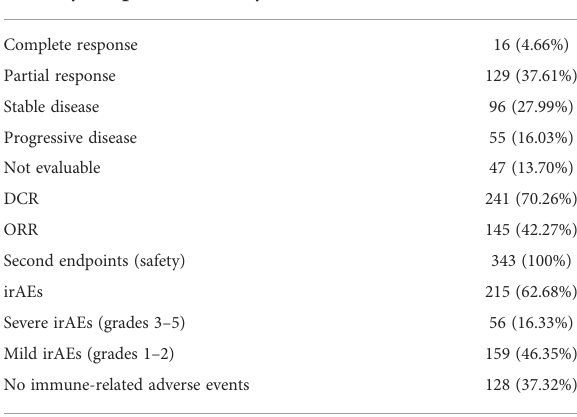
TABLE 2 The evaluated treatment ef fi cacy by RECIST1.1.